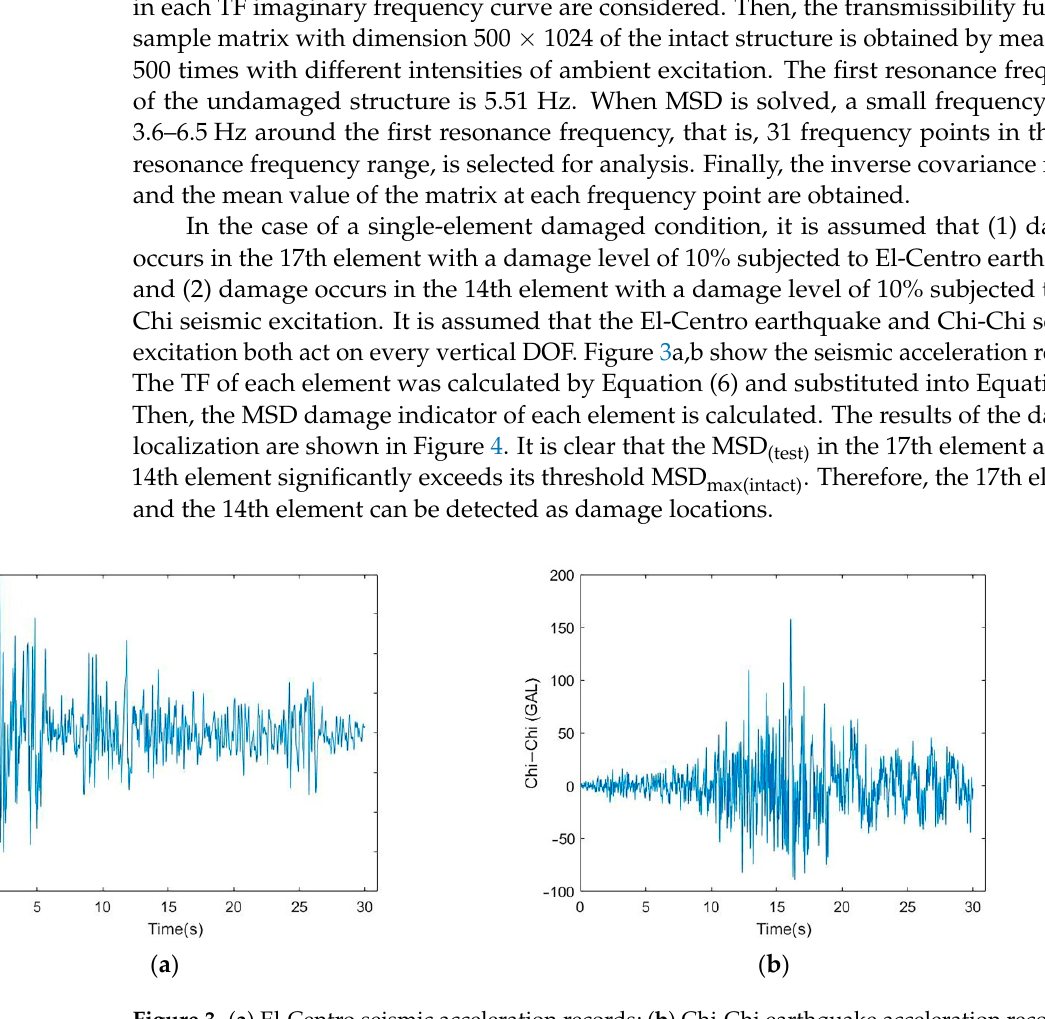
Figure 2. Finite element model of the simply supported beam.